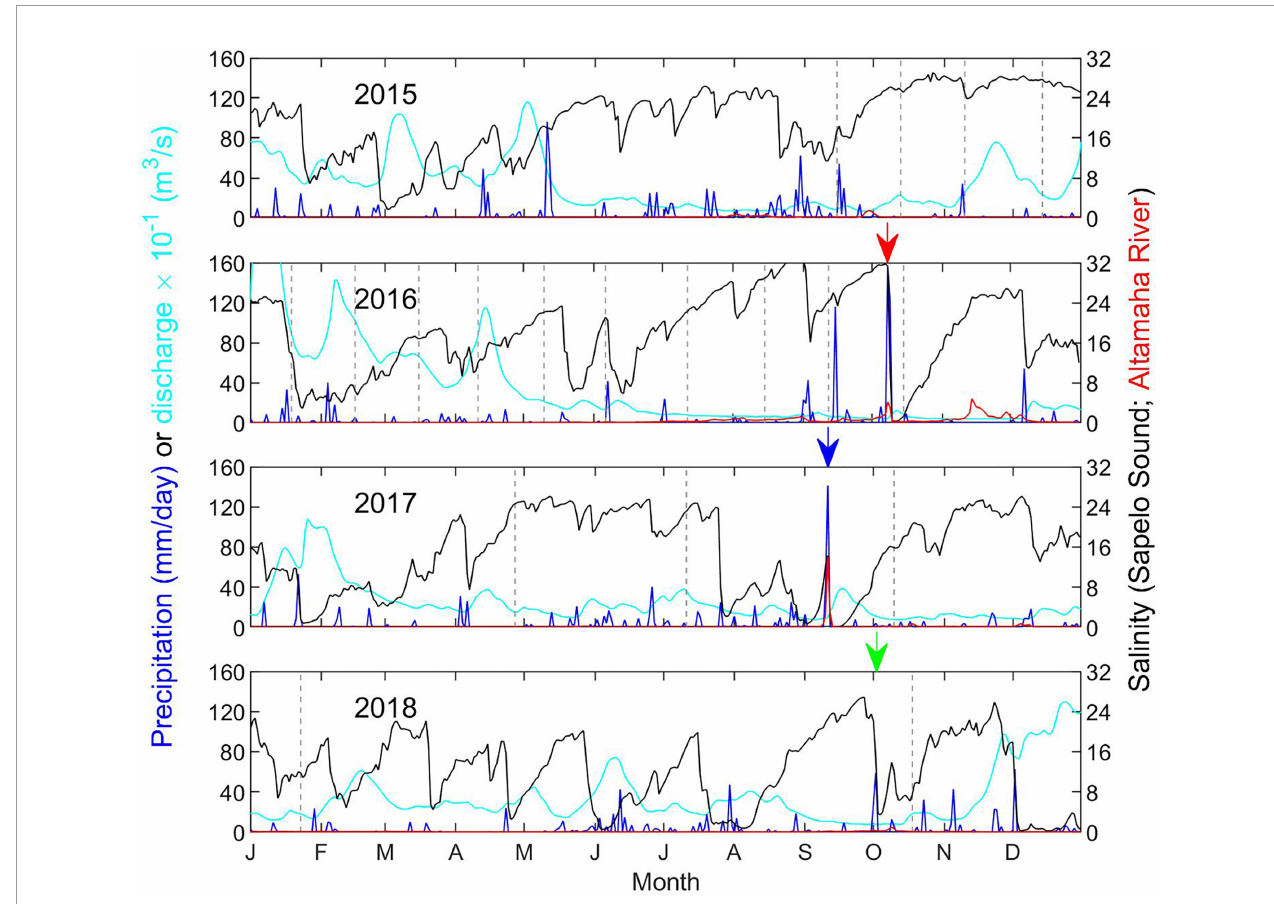
FIGURE 2 | Time series of Altamaha River discharge at Doctortown, Georgia, U.S.A. (cyan, divided by 10), precipitation at Marsh Landing (blue), salinity at the Altamaha River (red) and Sapelo Sound (black) sites. Vertical gray dashed lines indicate sampling periods. Red and blue arrows indicate timing of the passage of Hurricanes Matthew and Irma, while green arrow indicates timing of high precipitation event during fall 2018. Sampling in October 2016 was restricted to Sapelo